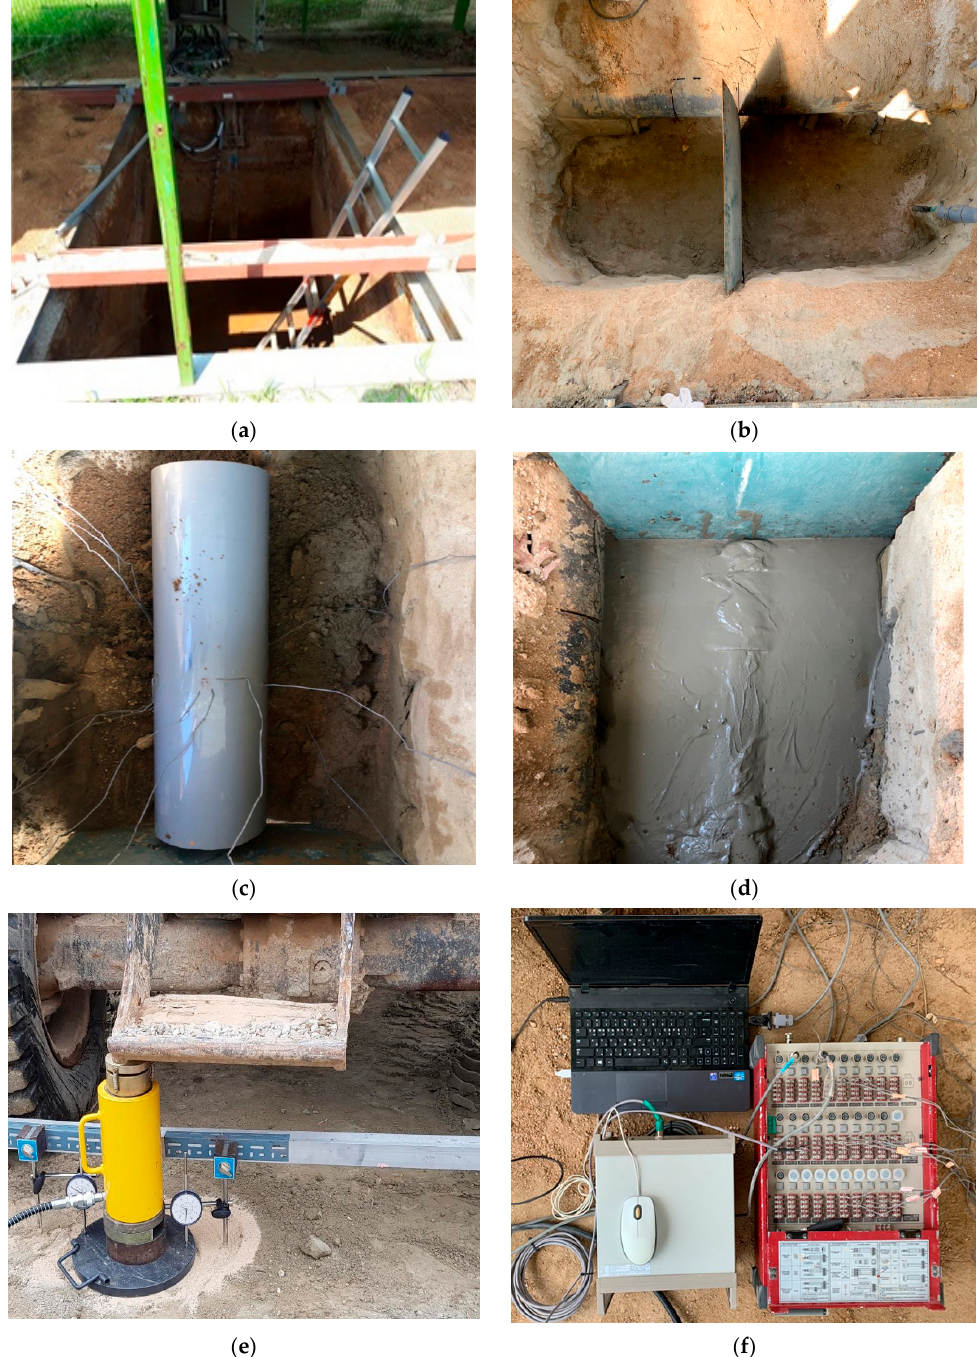
Figure 12. Plate bearing test procedure: ( a ) ground excavation and soil box installation; ( b ) ground construction; ( c ) buried sewage pipe; ( d ) CLSM construction; ( e ) plate bearing test; ( f ) test